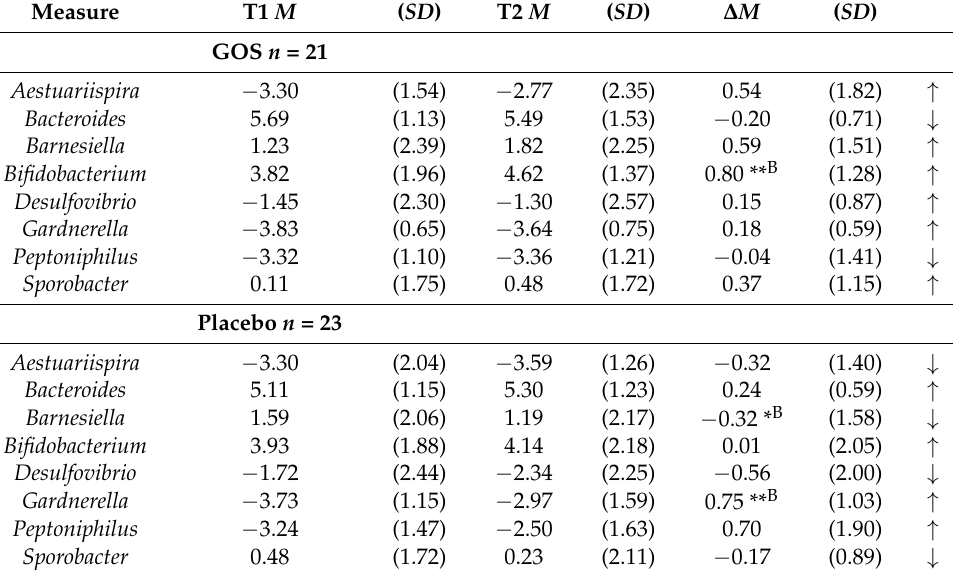
Table 2. Descriptive measures of influential genera expressed as a percentage of total gut bacteria counts pre and post intervention in young women, by treatment group.